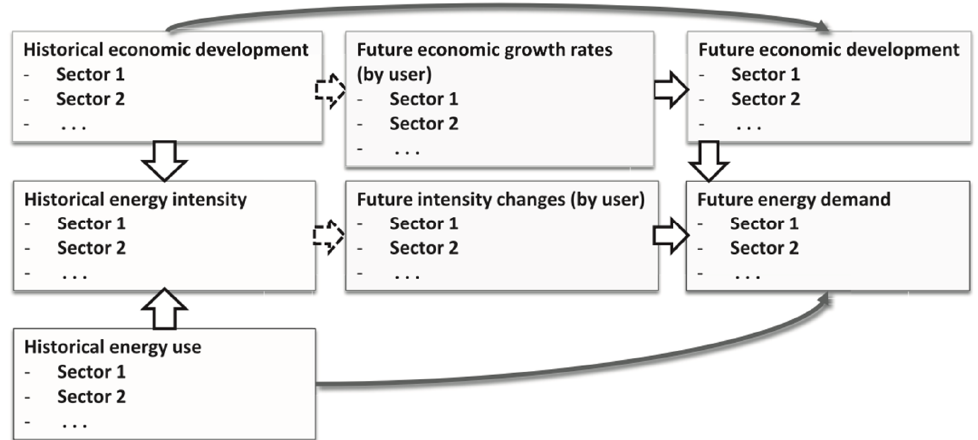
Figure 1. Calculation procedures based on the historical development and user inputs to define future energy demand